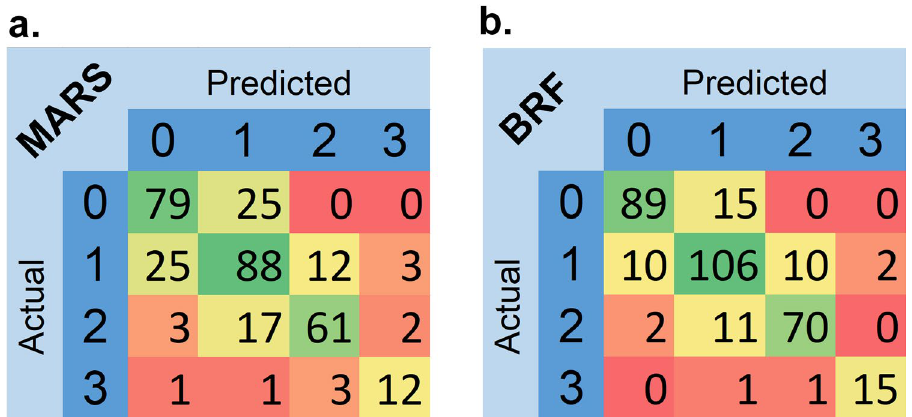
Figure 4. Four-by-four confusion matrix for ( a ) Multivariate Adaptive Regression Splines (MARS) and Bagging Random Forests (BRF).